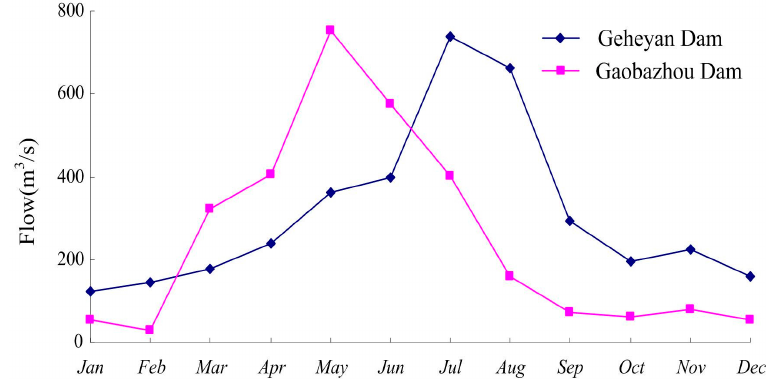
Figure 3. Mean monthly flows in the Geheyan and Gaobazhou Dams in the period 2000–2004.